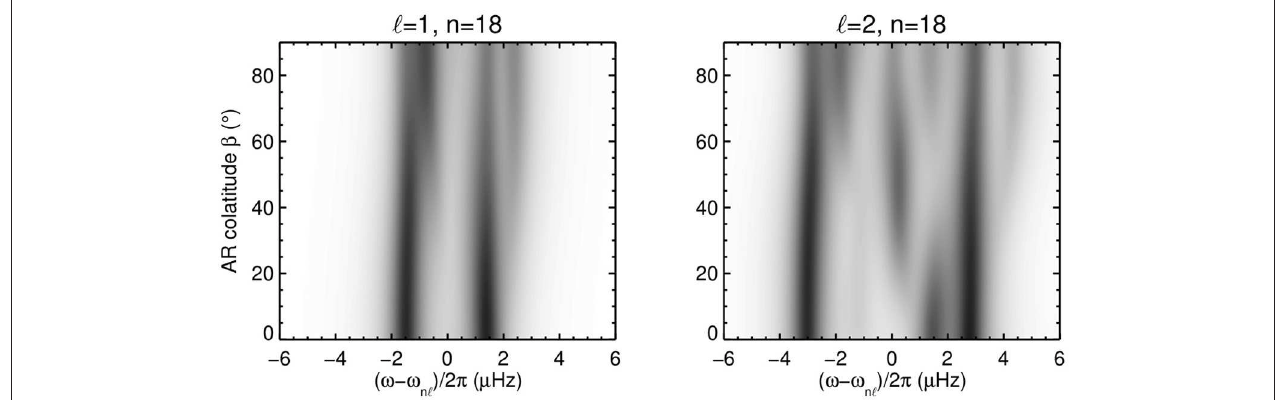
FIGURE 6 | Expectation value of power spectra of oscillation, as functions of active-region colatitude β , at fixed inclination angle i = 80 ◦ . The other physical parameters are the same as in Figure 5 .